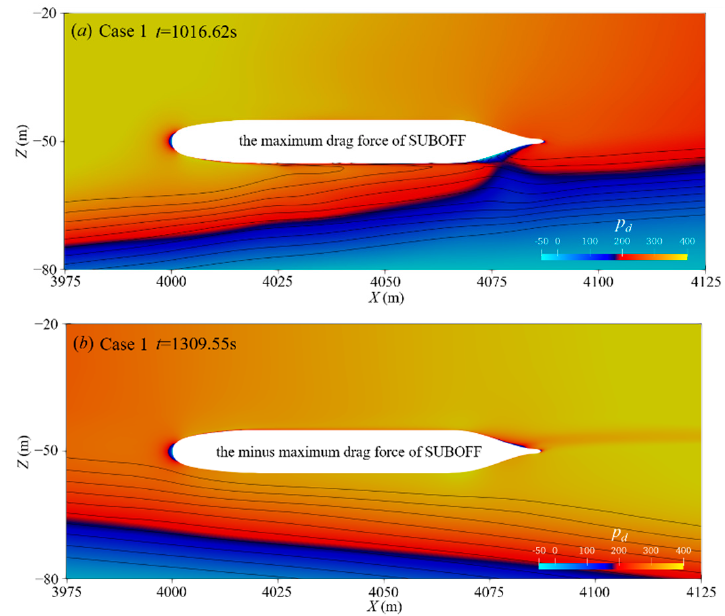
Figure 13. Dynamic pressure field around the SUBOFF.